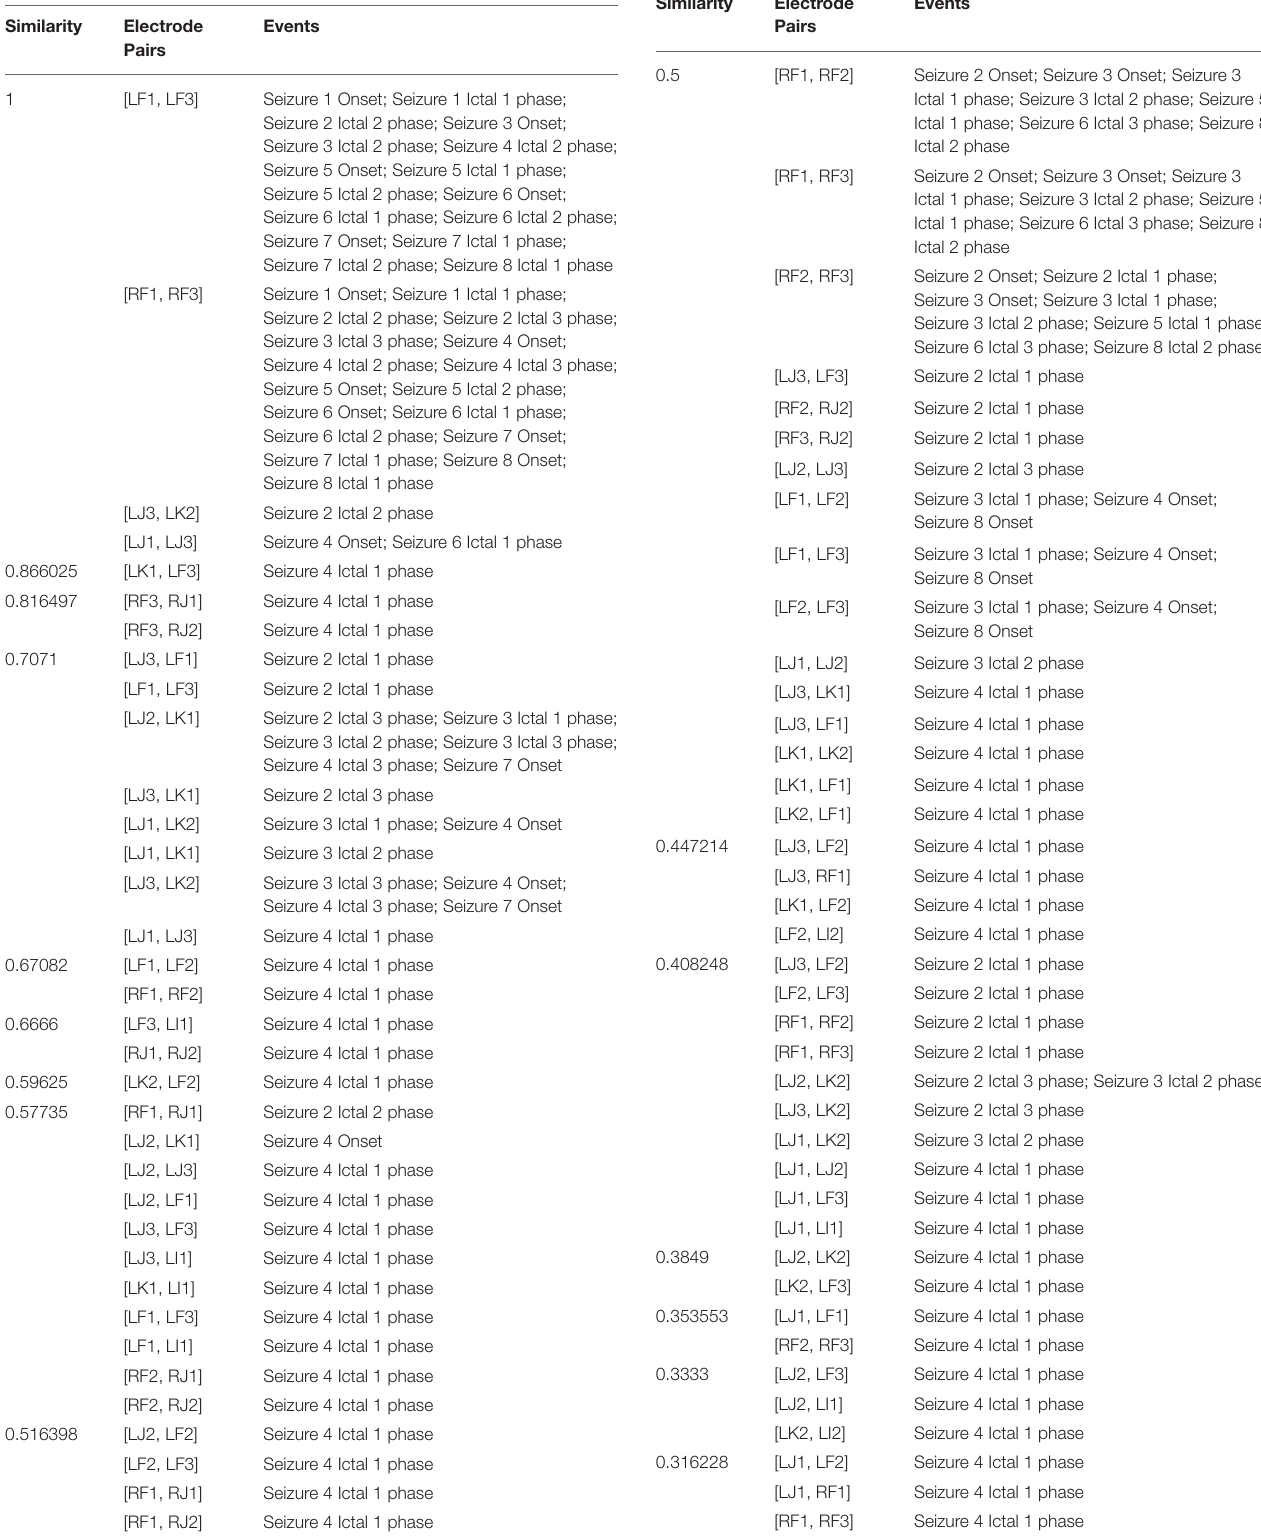
TABLE 3 | Grouping of electrode contact pairs by cosine similarity values with corresponding seizure events.